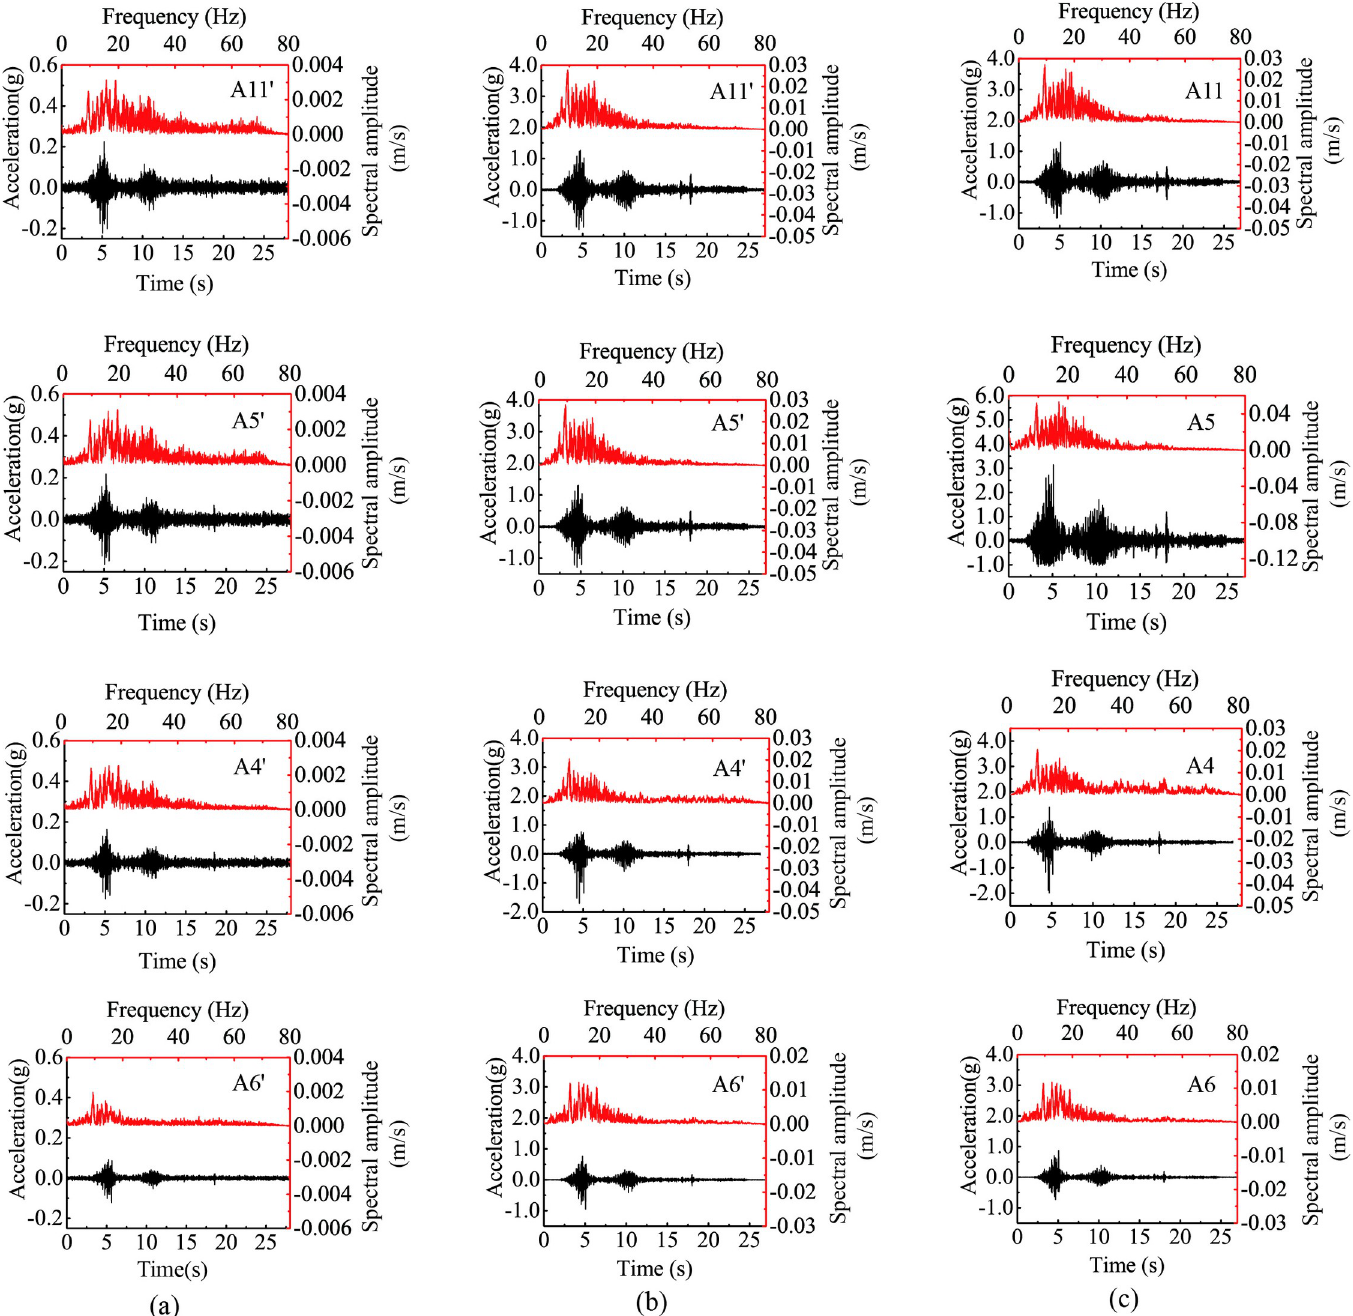
Fig 4. Horizontal acceleration responses at different monitoring points of two model slopes under 0.1 g and 0.8 g levels of horizontal shaking: (a) input amplitude = 0.1 g, Slope A, (b) input amplitude = 0.8 g, Slope A, (c) input amplitude = 0.8 g, Slope B.